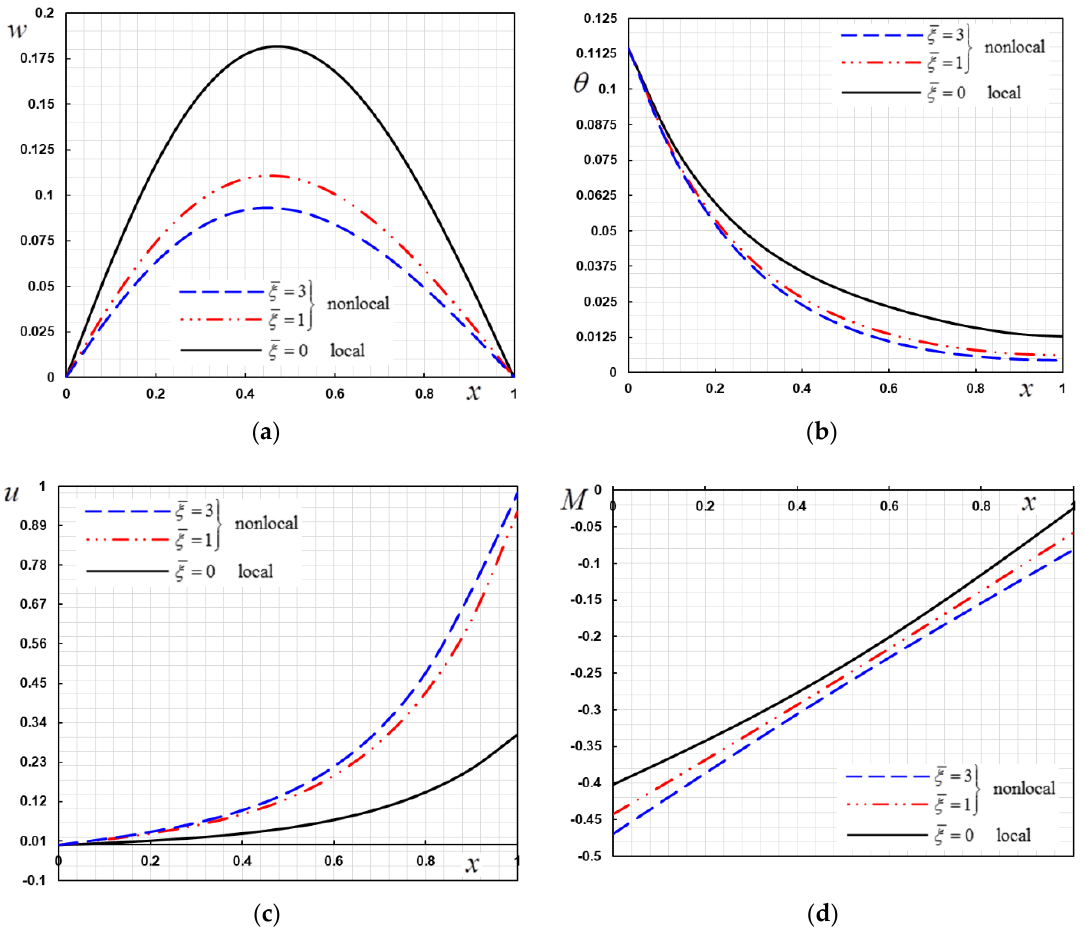
Figure 2. ( a ): The deflection 𝑤 for different values of the nonlocal parameter 𝜉̅ . ( b ): The temperature θ for different values of the nonlocal parameter 𝜉̅ . ( c ): The displacement u for different values of the nonlocal parameter 𝜉̅ . ( d ): The distribution of bending moment 𝑀 for different values of the nonlocal parameter 𝜉̅ .